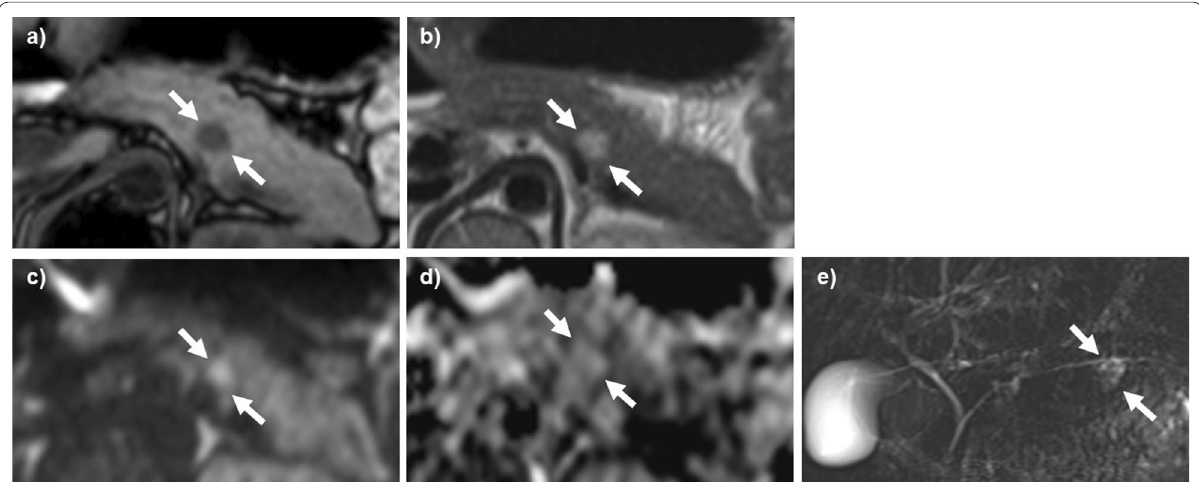
Fig. 2 MRI of the abdomen. a T1WI, b T2WI, c DWI, d ADC-map, and e MRCP. An abdominal MRI revealed a homogeneous mass with low intensity on the T1-weighted image (T1WI), and high intensity on the T2-weighted image (T2WI) and diffusion-weighted image (DWI) and a slightly high intensity on the apparent diffusion coefficient-map (ADC-map) in the pancreatic tail (white arrows in a – d ). A MRCP showed a high-intensity irregular lesion with slight indistinct margins without stenosis and dilatation of the main pancreatic duct in the tail of the pancreas (white arrow in e )